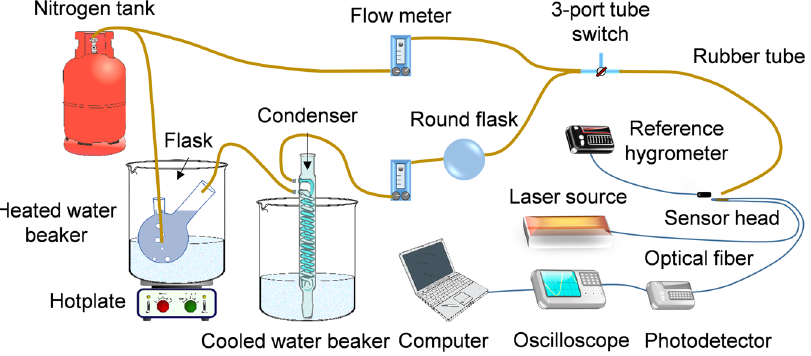
Figure 3. Schematic of the interrogation setup. Wet and dry nitrogen gas are injected through a series of components before being directed onto the sensor head. The optical transmission signal is converted into an electrical signal for data capture.